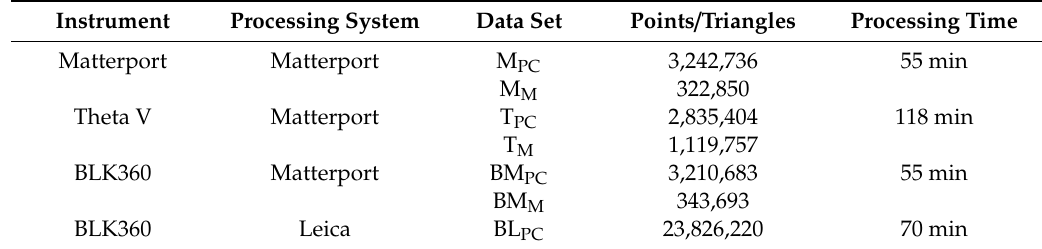
Table 4. Point and triangle counts for the obtained point clouds and meshes of the hall 101 test site, and the processing time required to obtain them.